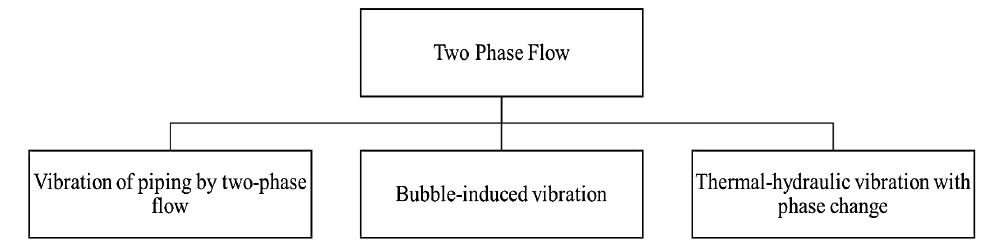
Figure 2. Classification of two-phase flow-induced